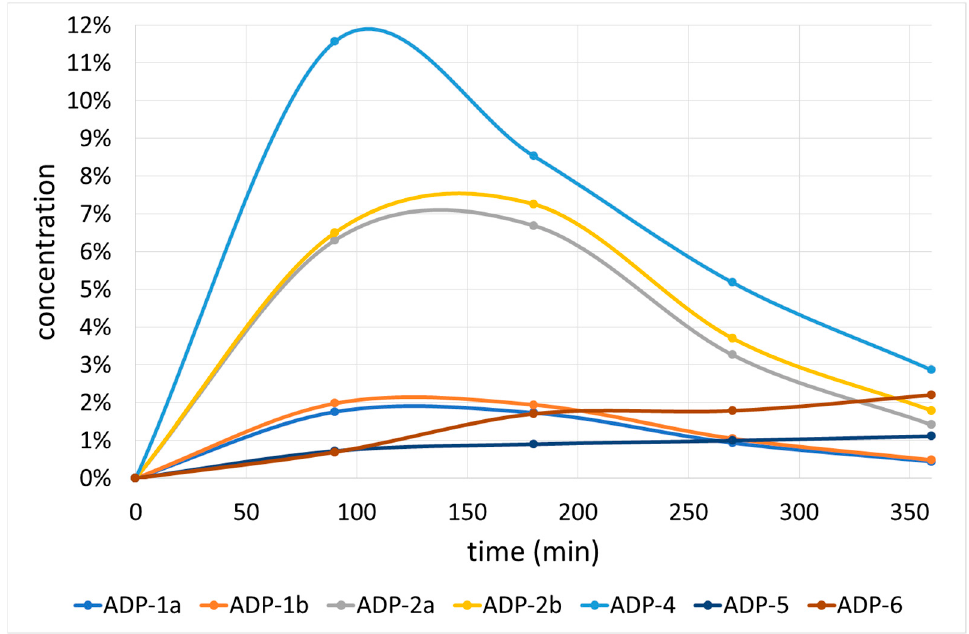
Figure 4. Time dependence of ceftobiprole decomposition in 1 M HCl at 70 °C.